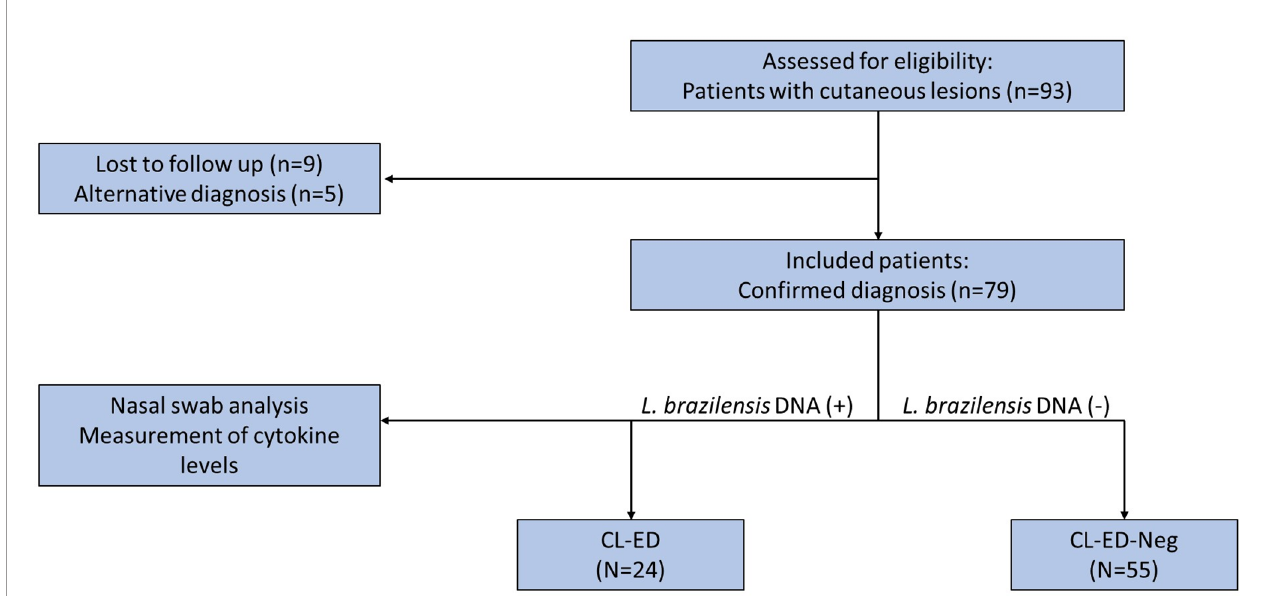
FIGURE 1 | Flow chart showing eligible and included patients as well as the fi nal group con fi guration. n, number of patients; CL-ED, cutaneous leishmaniasis with early dissemination to mucosa; CL-ED-Neg, cutaneous leishmaniasis without early dissemination to